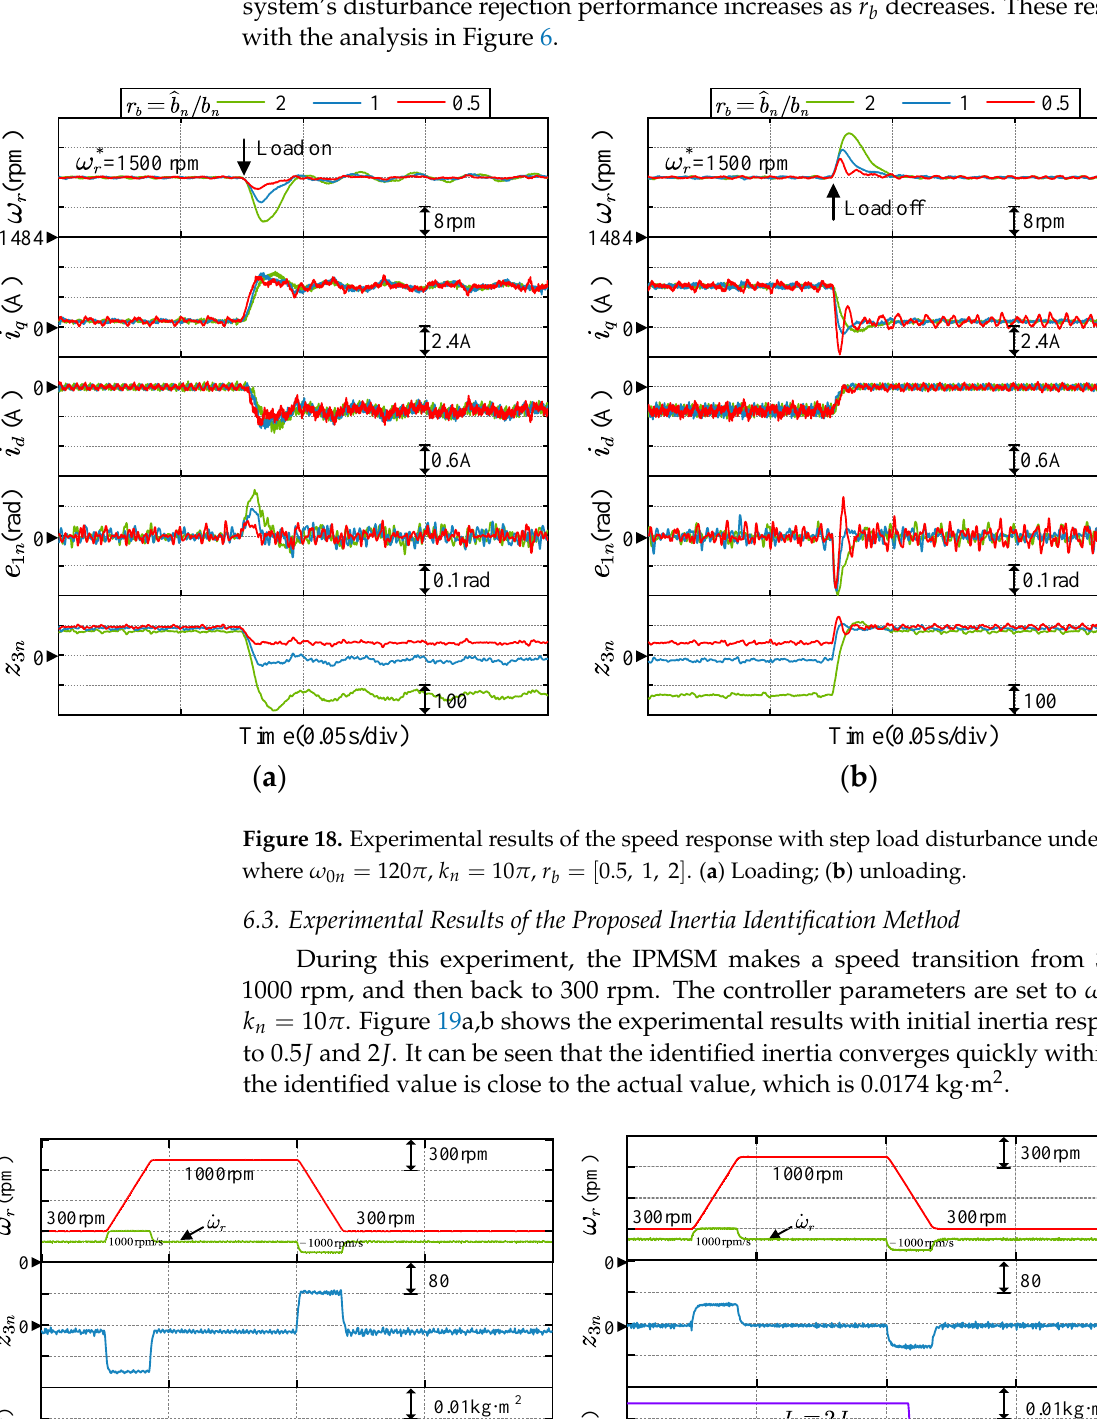
Figure 19. Experimental results of the proposed inertia identification method under different initial inertia. ( a ) J 0 = 0.5 J ; ( b ) J 0 = 2 J